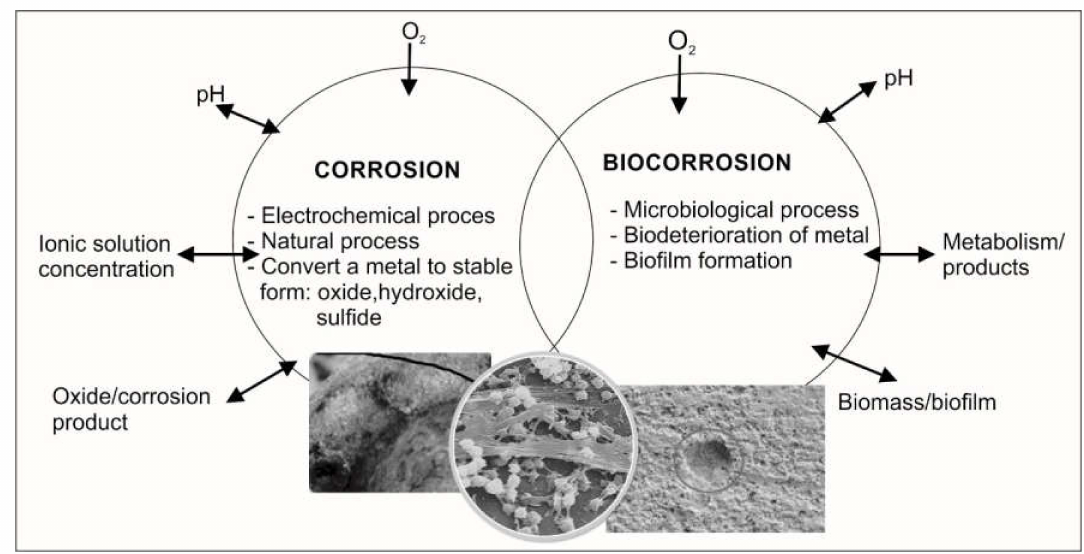
Figure 1. Corrosion versus